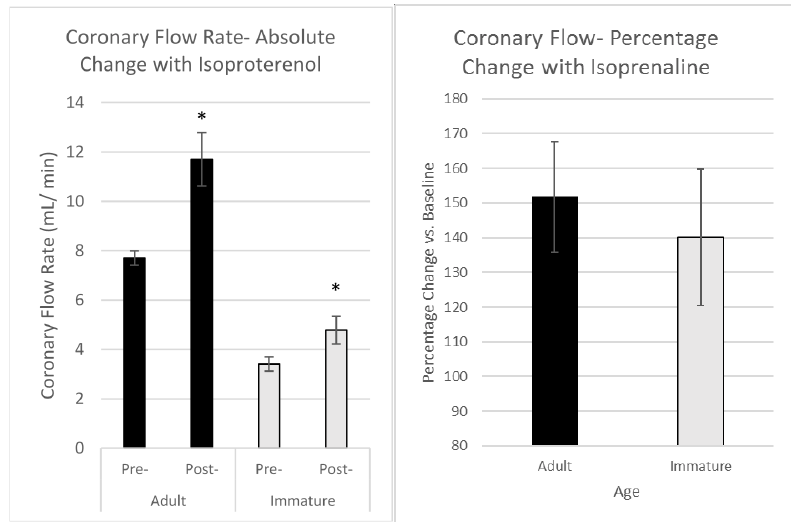
Figure 1. Maximal change in coronary flow measured in adult and immature hearts prior to (pre-) and following (post-) perfusion with 5 nM isoproterenol for 3 min. ( Left ) panel—absolute changes, ( Right ) panel—proportionate changes relative to control for each age group. Data points are mean ± SEM. * p < 0.05 vs. corresponding pre-values.